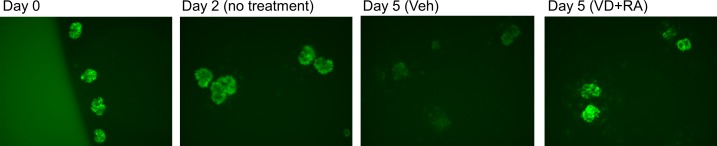
EGFP expression in cultured glomeruli from Nephrin-EGFP mice.On Day 2, EGFP expression remained mainly along the periphery of glomeruli, but was markedly reduced on day 5. FBS concentration was reduced from 10% to 0.5% on day 3. Treatment with 1α,25-(OH)2 vitamin D3 (VD, 50 nM) and all trans-retinoic acid (RA, 1 μM) for the last 2 days induced EGFP expression. Veh, vehicle. Magnification, 10x.